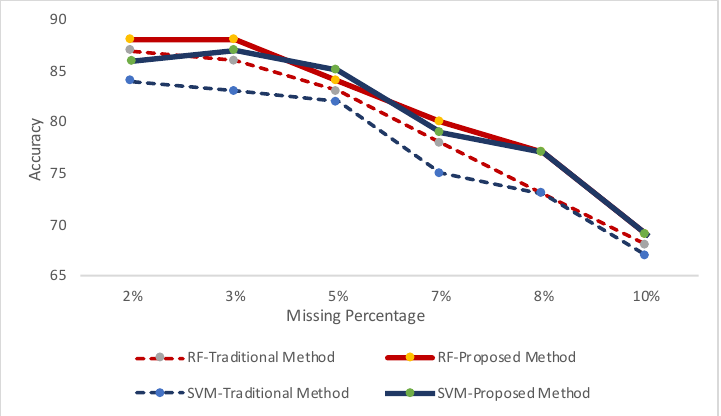
Figure 7. Recognition results for clean data for both datasets (in %).